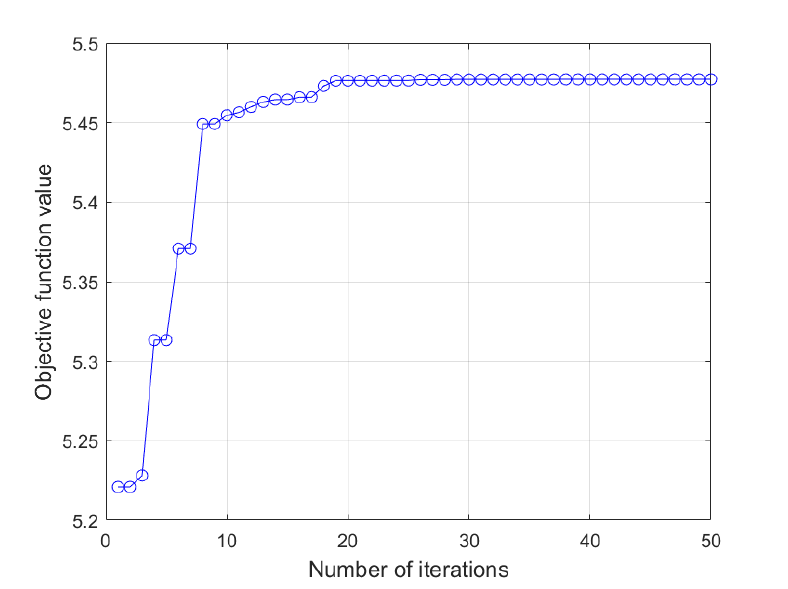
Figure 4. Algorithm iterative